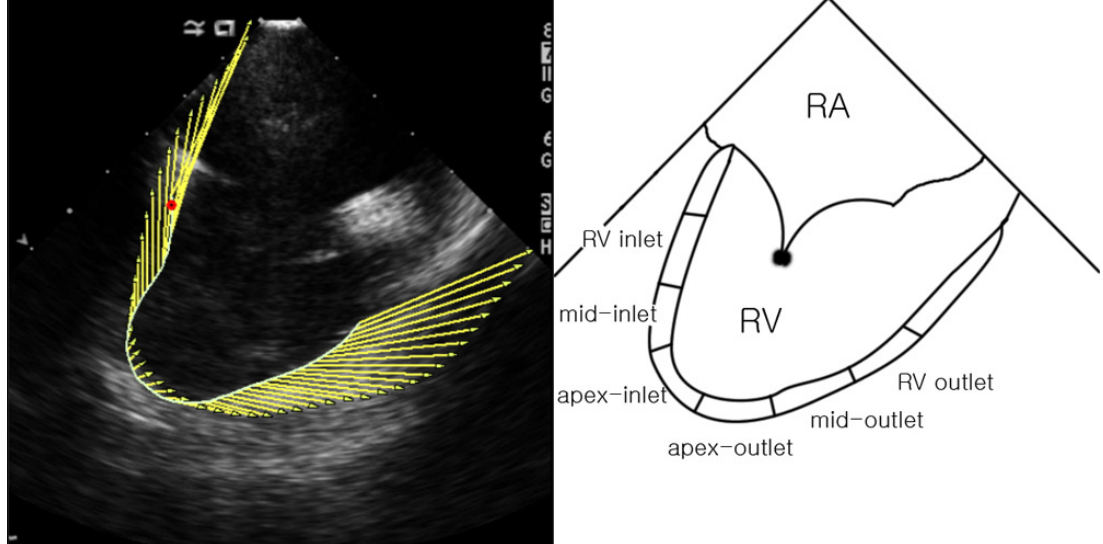
Figure 2. Vector velocity image of the right ventricle in “home view”. RA: right atrium, RV: right ventricle. The right ventricle was divided into six segments, and the velocity, strain, strain rate, and longitudinal displacement of each part was analyzed from the vector velocity image obtained in “home view”.